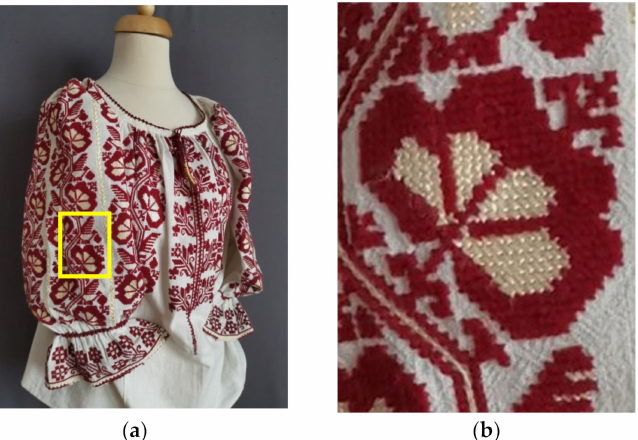
Figure 1. “Ie”, traditional woman’s blouse from a private collection from Transylvania region: ( a ) Ensemble view; ( b ) Detail of the stitched